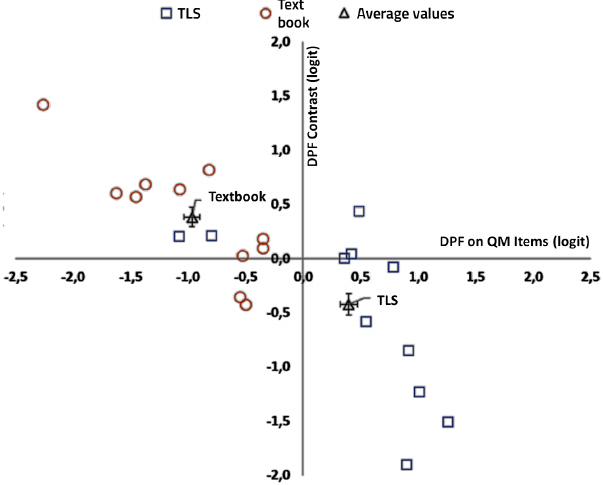
FIG. 5. Correlation between average ability on QM items (horizontal axis) and DPF contrasts (vertical axis) of the classes involved in the study. Blue squares denote the TLS group, while red circles are used for the textbook group. The average values for the two groups are denoted by triangles. Note that students of one class did not answer to the confidence tier, so only 22 points are represented in the graph.